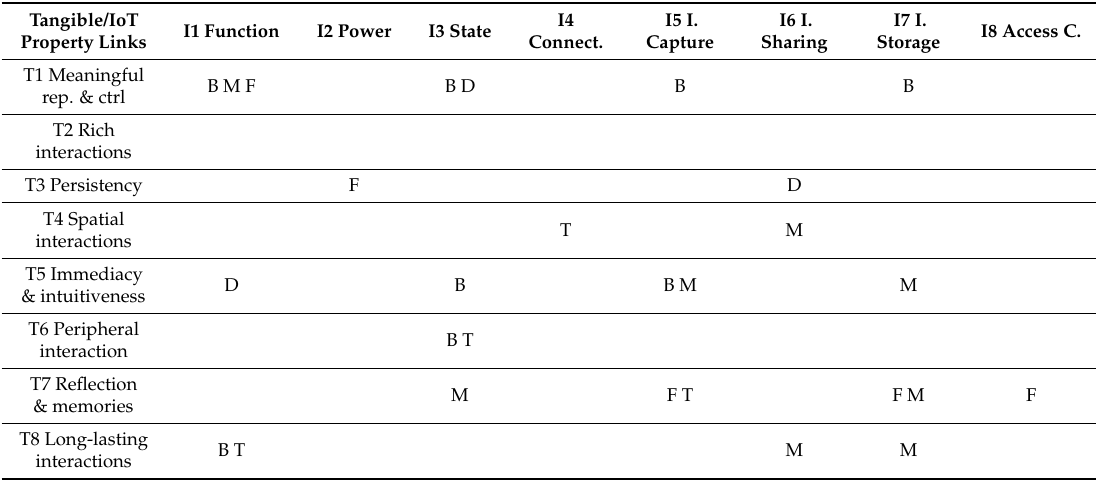
Table 3. Links between tangible properties and IoT properties. B = Bobby, D = DUC, E = Eisenhower Matrix, F = Fitfoot, M = Museum Memories, T =